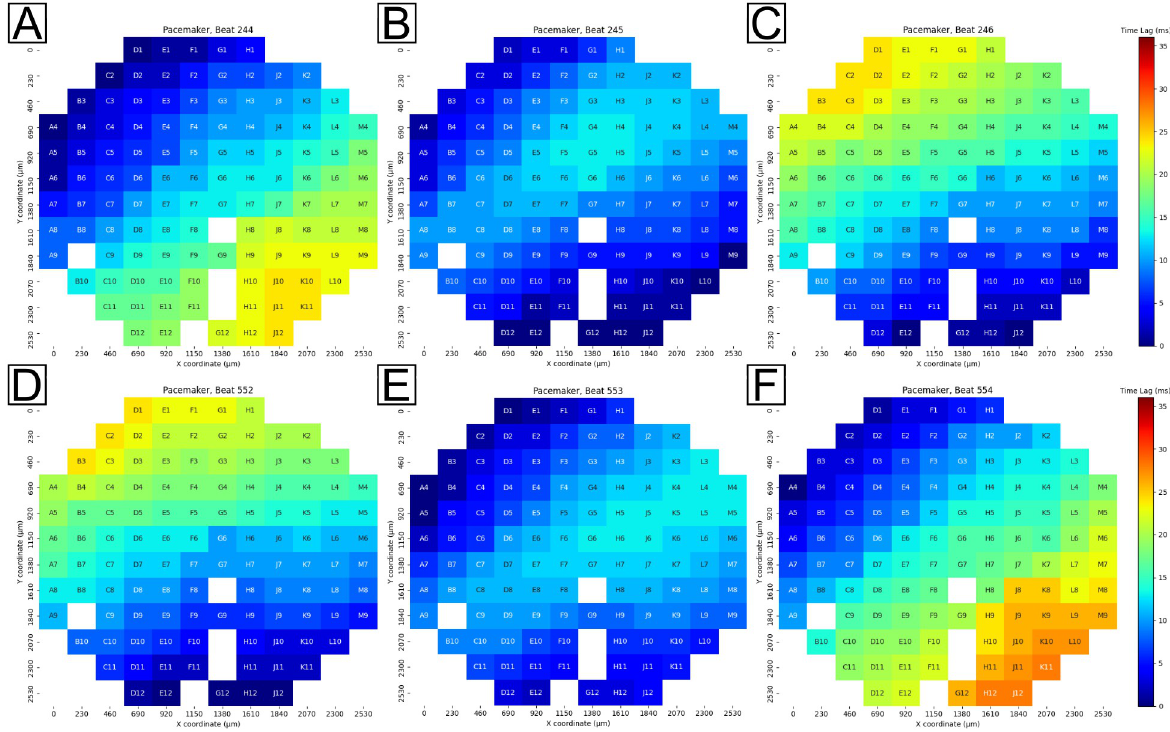
Fig 3. Example pacemaker translocations observed in one recording of a 120 electrode MEA. Color bar is normalized from the lowest time lag (0 milliseconds, dark blue) to highest time lag (35 milliseconds, dark red) in the full recording. Top row: the pacemaker region translocates from the top-left corner of the array (A) to a temporary regime positioned simultaneously in the top-left and bottom-right corners (B) before stabilizing in the bottom-right corner of the array (C). Bottom row: another translocation event observed in the same recording over 300 beats later that follows a similar pattern as A-C. The pacemaker is stable in the bottom-right (D) until translocating to a temporary regime positioned simultaneously in the top-left and bottom-right corners (E) before settling in the top-left corner of the array (F). https://doi.org/10.1371/journal.pone.0263976.g003 PLOS ONE | https://doi.org/10.1371/journal.pone.0263976 March 14,